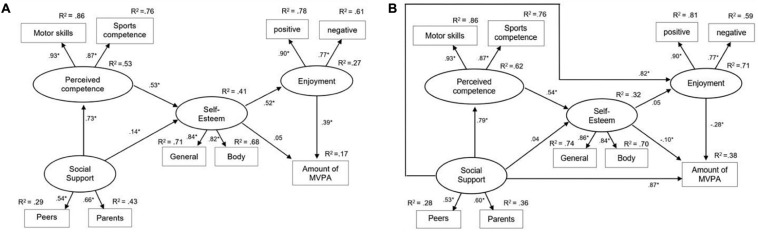
Original (A) and adapted model (B) for Study 2. Standardized regression weights are presented next to the arrows with ∗p < 0.05.